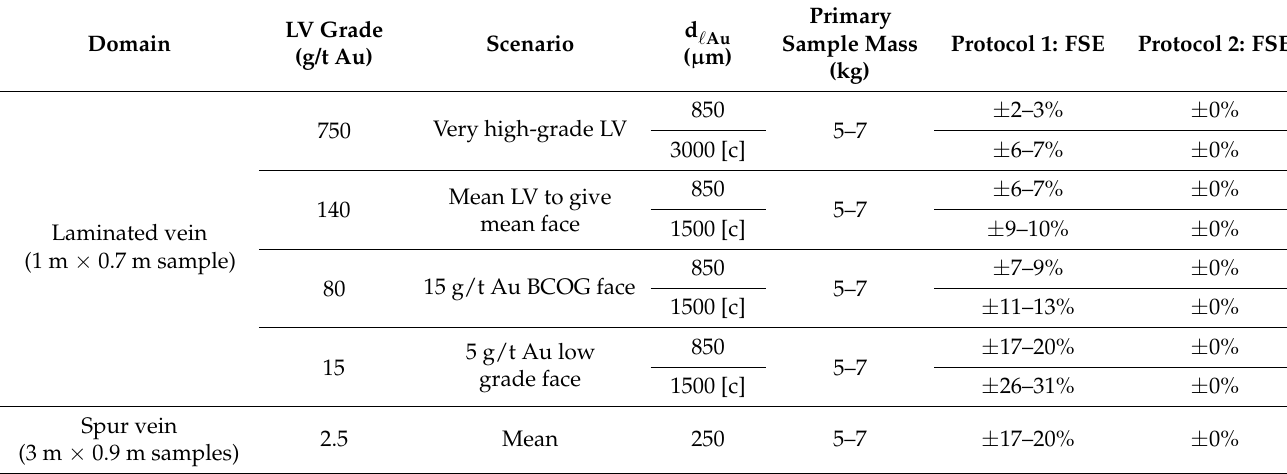
Table 23. Based on original grade control sample mass the FSE values for optimised sample preparation and PhotonAssay by vein domain for different grade-liberation diameter scenarios. The primary sample mass is based on a 0.7 m wide LV and 2.8 m of spur vein. Recommended sampling protocol as noted in Table 22. [c]: clustered gold values.